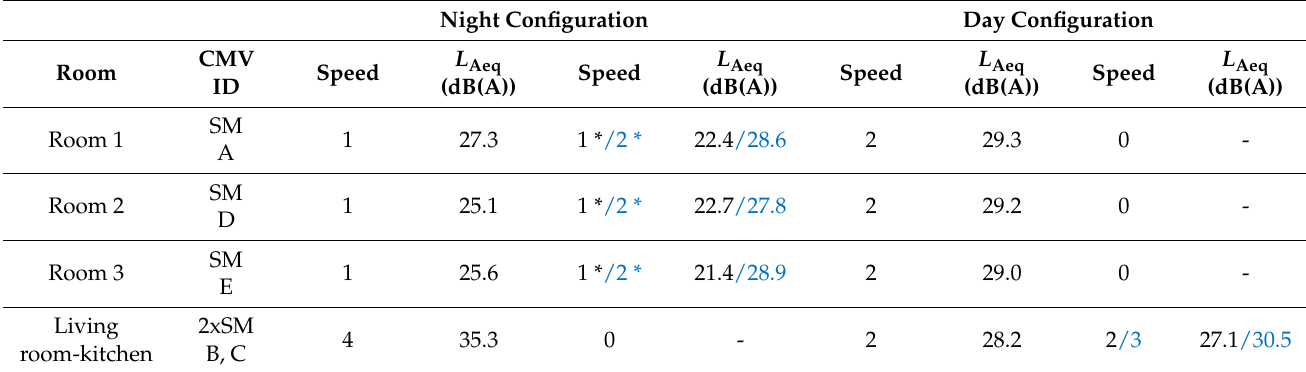
Table 11. Four-room apartment. Night and day configurations (in blue 0.5 1/h single CMV speed).